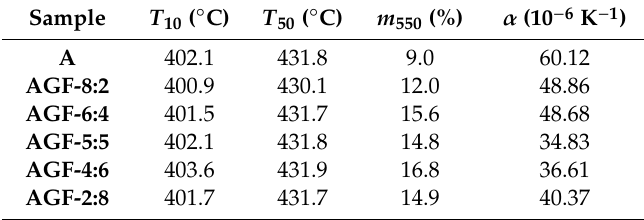
Table 11. Thermal properties of the prepared composite materials–virgin PETG with EG and CF. Sample